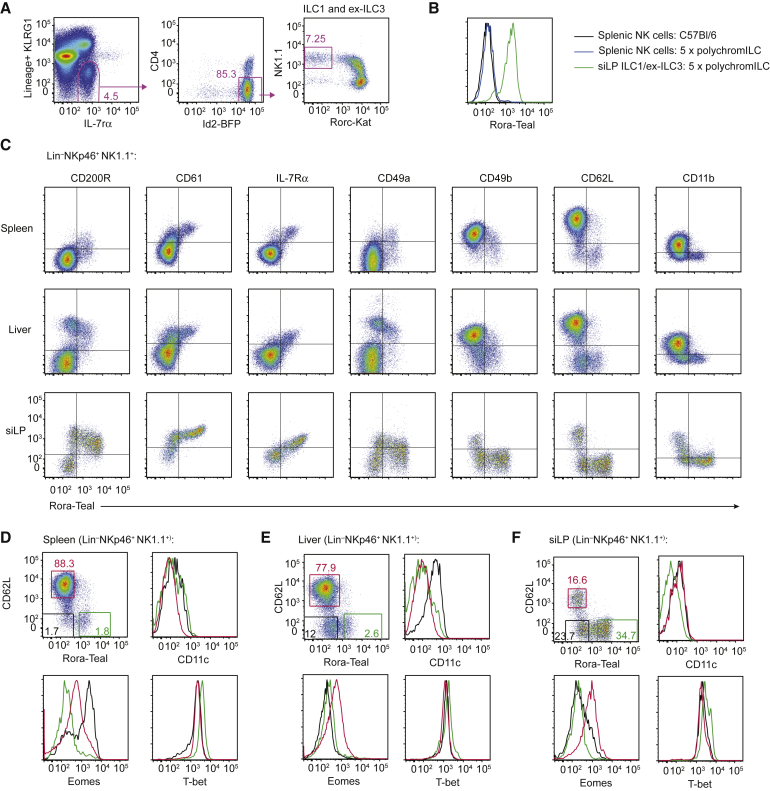
Rora-Teal Expression Distinguishes ILCs from NK Cells(A) Flow-cytometry gating strategy for ILC1 or ex-ILC3 in the siLP of 5x polychromILC mice.(B) Flow-cytometry analysis of Rora-Teal expression in splenic NK cells (CD3−CD19−NKp46+NK1.1+) and siLP ILC1or exILC3 (gated as shown in A) from 5x polychromILC mice.(C) Flow-cytometry analysis of the indicated cell surface markers in Lin−NKp46+NK1.1+ cells from the spleen, liver, and siLP of Rora+/Teal mice.(D) Flow-cytometry analysis of CD11c, Eomes, and T-bet expression in NK or ILC1 cells from the spleen of Rora+/Teal mice.(E) Flow-cytometry analysis of CD11c, Eomes, and T-bet expression in NK or ILC1 cells from the liver of Rora+/Teal mice.(F) Flow-cytometry analysis of CD11c, Eomes, and T-bet expression in NK or ILC1 cells from the siLP of Rora+/Teal mice.Data are representative of 2 independent experiments.